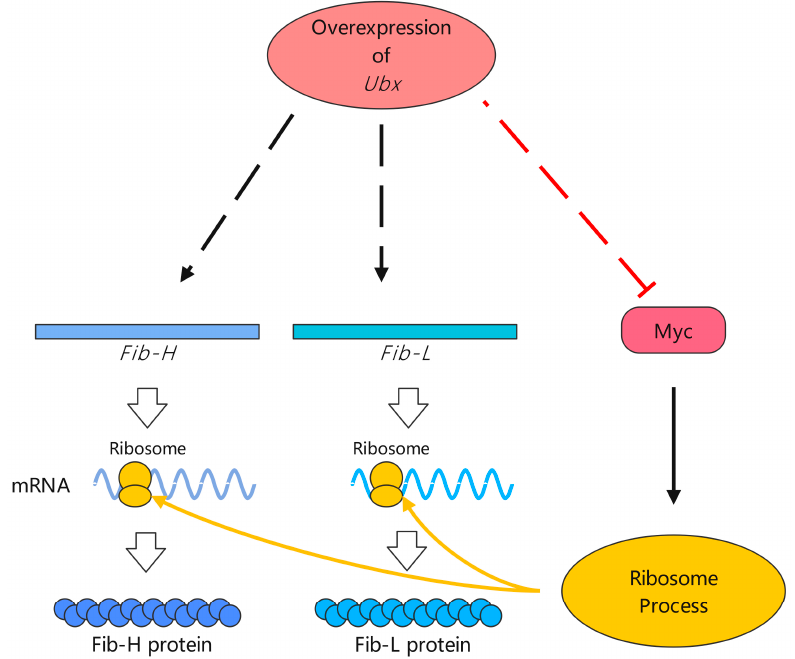
Figure 7. Presumptive model of the expression of fibroin regulated by overexpressing Ubx . Overexpression of Ubx increased expression of Fib-H and Fib-L but inhibited the expression of Myc . Decrease in Myc impacted the synthesis of ribosomes. Therefore, the mRNA of Fib-H and Fib-L was increased but the content of fibroin protein was not significantly changed. Arrow indicates activation and “T” indicates inhibition. Solid line indicates direct regulation. Dashed line indicates indirect regulation or indeterminate direct regulation.